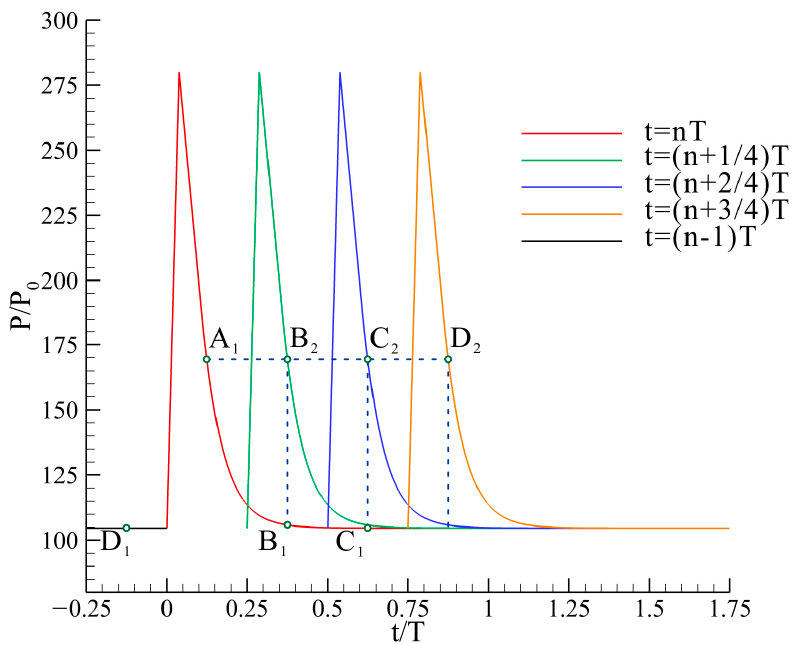
Figure 18. Feedback pressure change curve with time, where points A 1 , B 1 , C 1, and D 1 denote the meridian plane with θ = 135°, 225°, 315°, and 45° at t = n T successively, point B 2 denotes that with θ = 225° at t = (n + 0.25) T , point C 2 denotes that with θ = 315° at t = (n + 0.5) T , and point D 2 denotes that with θ = 45° at t = (n + 0.75) T .